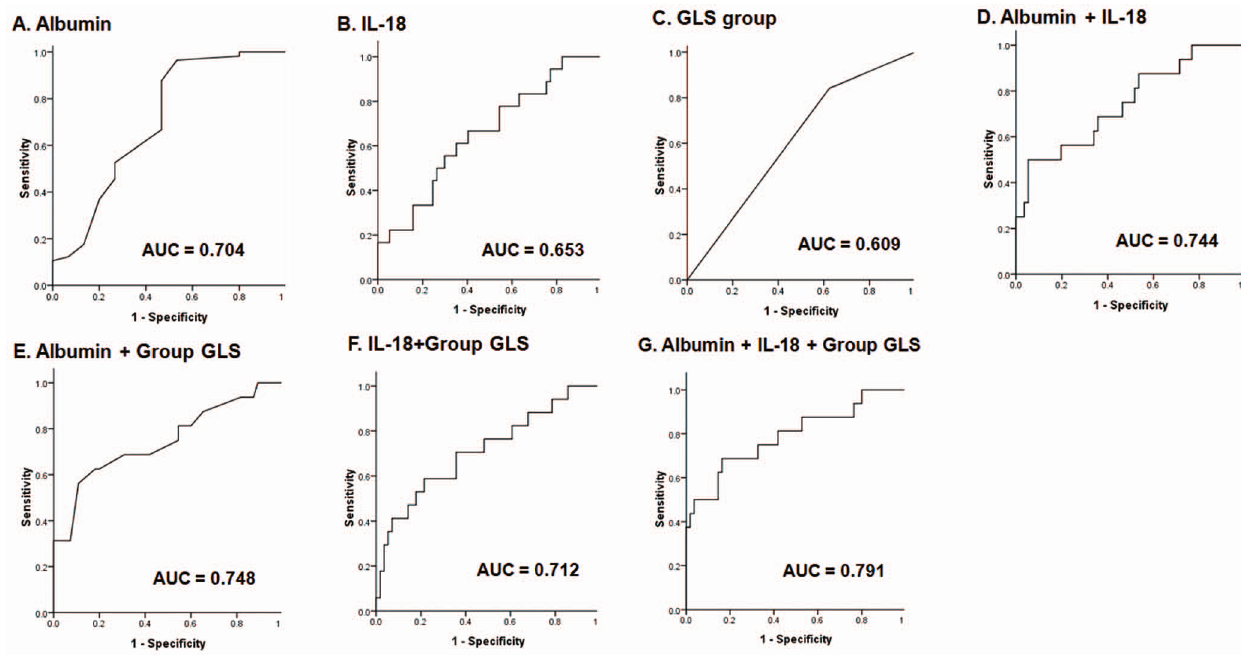
Figure 3. Receiver operating characteristic (ROC) curve of the ability of serum albumin (A), serum interleukin (IL)-18 (B), left ventricular global peak systolic longitudinal strain (GLS) group (C), the 2-combination parameters (D–F), and the 3-combination parameter (G) to predict all-cause mortality in clinical stable hemodialysis patients.